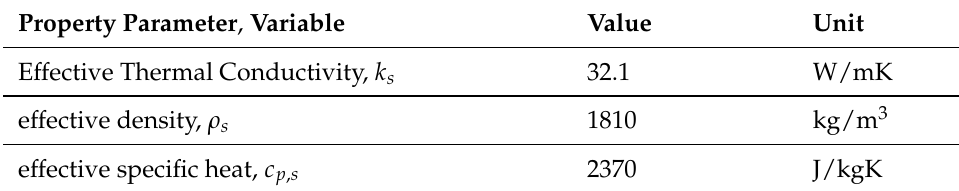
Table 4. Effective Properties: Storage Matrix.